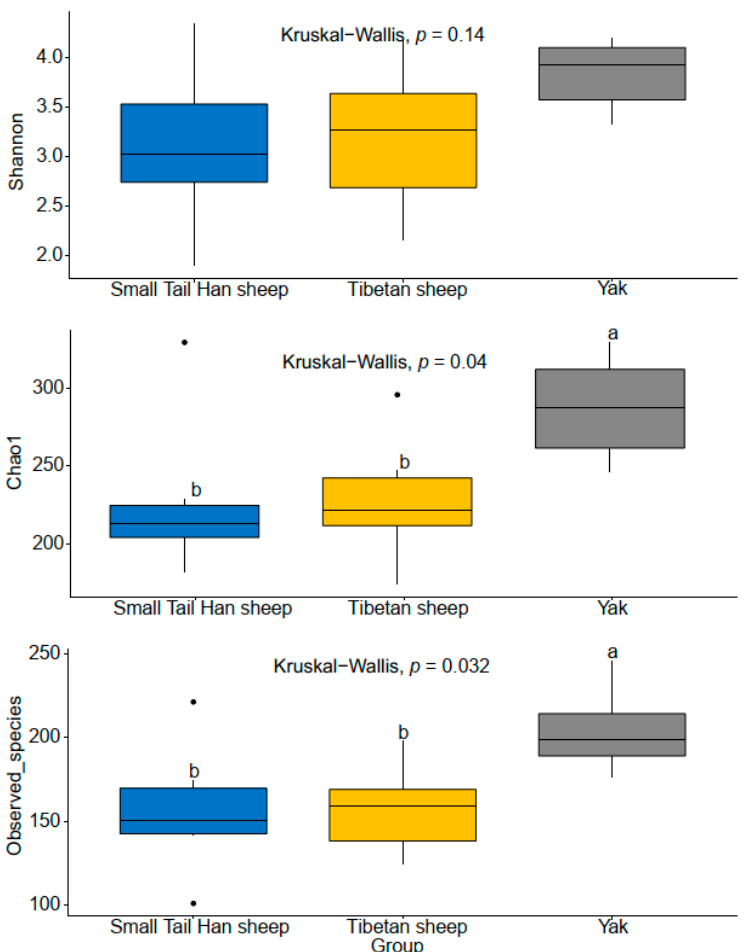
Figure 2. Alpha diversity indices Shannon, Chao1 and Observed_species derived from Tibetan sheep, Small Tail Han sheep and Yak. The Wilcoxon test was used to determine the significant level between two animal groups, while Kruskal − Wallis test was used to calculate the significant level among animal groups, and the p value was adjusted using Benjamini − Hochberg method. a, b = different letters indicate a significant difference between animal species ( p < 0.05).